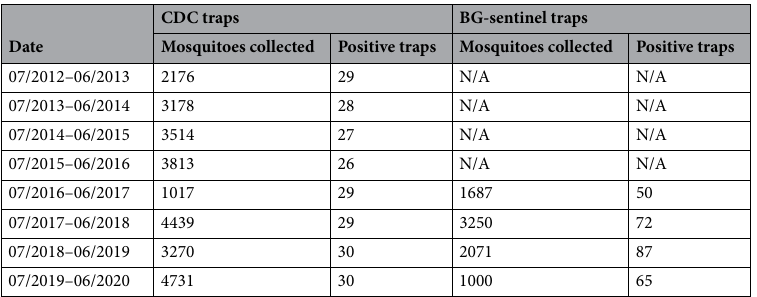
Table 1. Species from the Culex coronator complex collected in Miami-Dade County, Florida from 2012 to 2020 by the CDC and BG-Sentinel